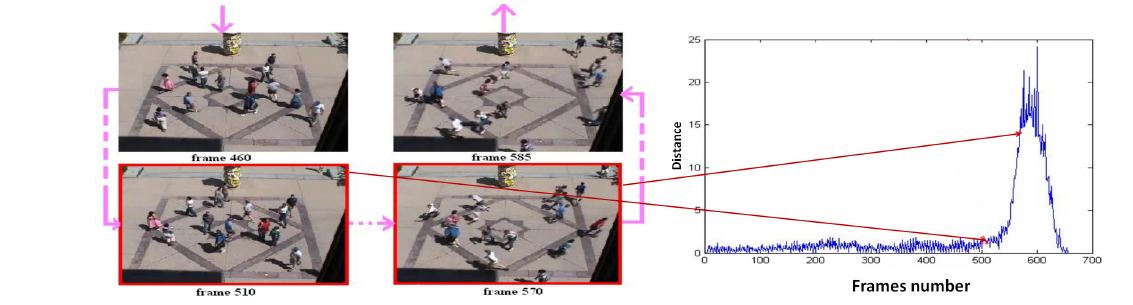
Figure 5. Event detection in crowd videos